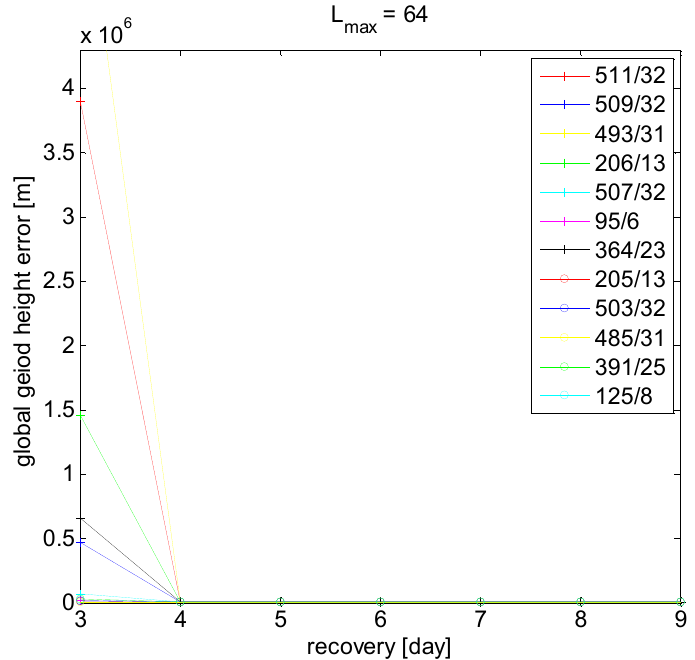
Figure 2. Error RMS in terms of geoid height for the gravity solutions of the Table 1 mission scenarios for maximum spherical harmonic degree and order 64.